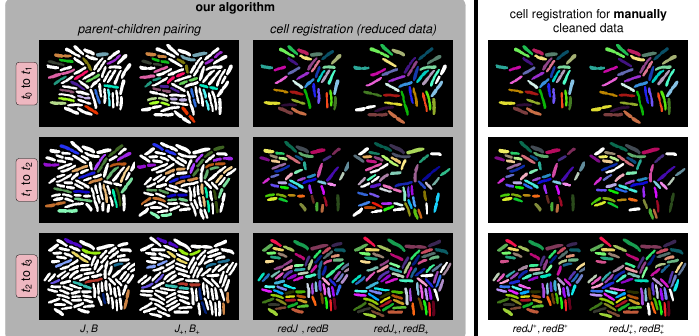
Figure 8. Cell tracking results for the short image sequence COL2 in Figure 6. The interframe duration for COL2 is six minutes. COL2 involves four successive images J ( t i ) , i = 0,1,2,3. In our figure, each one of the three rows displays the automatic cell registration results between images J ( t i ) and J ( t i + 1 ) for i = 0,1,2. We report the accuracies of parent–children pairing and of the registration in Table 5. ( Left column ): Results for parent–children pairing. Each parent–children triplet is identified by the same color for each parent cell and its two children. ( Middle column ): Display of the automatically computed registration after removing the parent–children triplets already identified in order to generate two reduced sets redB and redB + of cells. Again, the same color is used for each pair of automatically registered cells. The white cells in redB + are cells which could not be registered to some cell in redB . ( Right column ): To differentiate between errors induced during automatic identification of and errors generated by automatic registration between redB and redB + , we manually removed all “ true ” parent–children triplets and then applied our registration algorithm to this “ cleaned ” (reduced) cell sets redB ∗ and redB ∗ + . Table 4. Cost function weights for parent–children pairing in the COL1 images displayed in Figure 6.